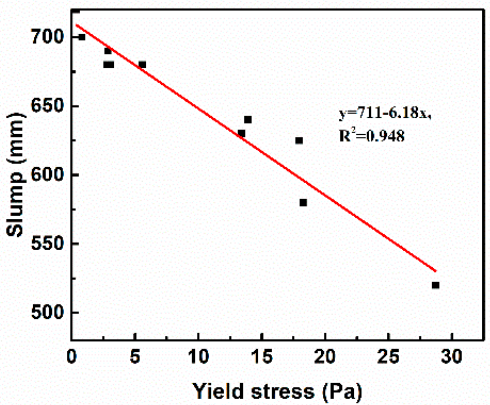
Figure 7. Relationship between yield stress and slump flow of SCC.